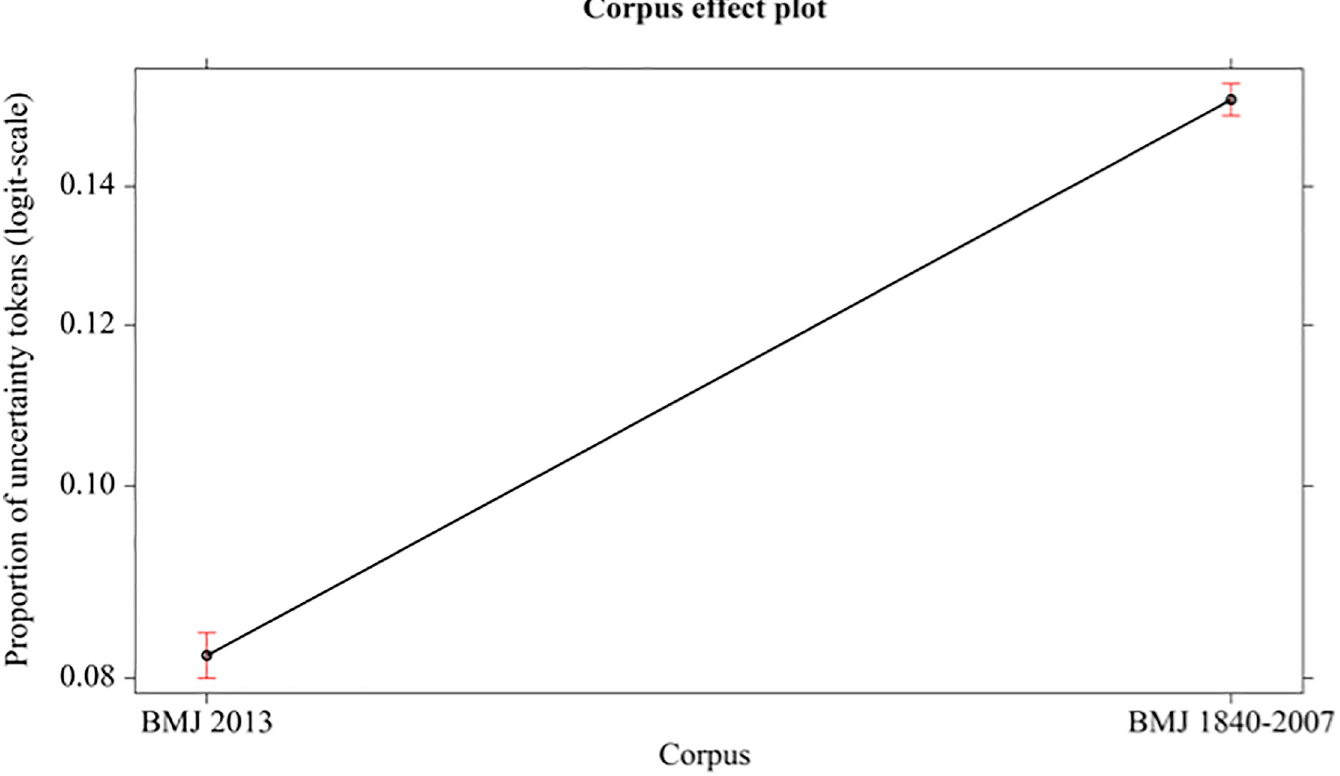
Fig 5. Mean proportions (95% confidence interval) of uncertainty tokens (in logit-scale) of different corpus (BMJ 2013, BMJ 1840–2007 IMRaD articles).